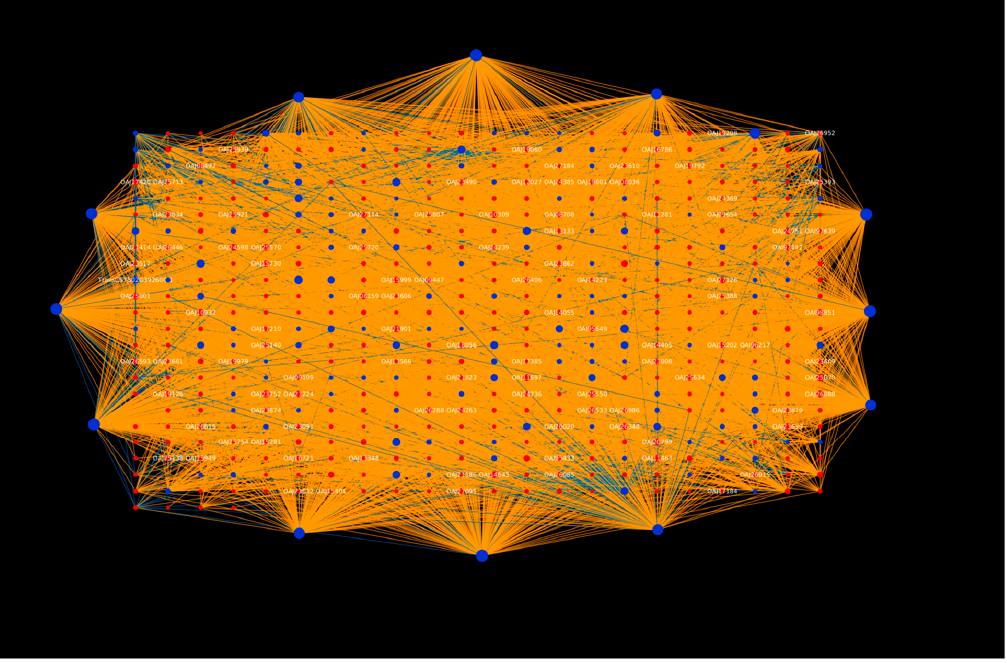
Figure 4. Visualization of the top GO term (GO:0048229, gametophyte development) from the biological process category. Blue nodes represent host proteins, red nodes are pathogen proteins. Orange edges depict the interactions from the interolog-based approach, while blue edges belong to the domain-based approach.